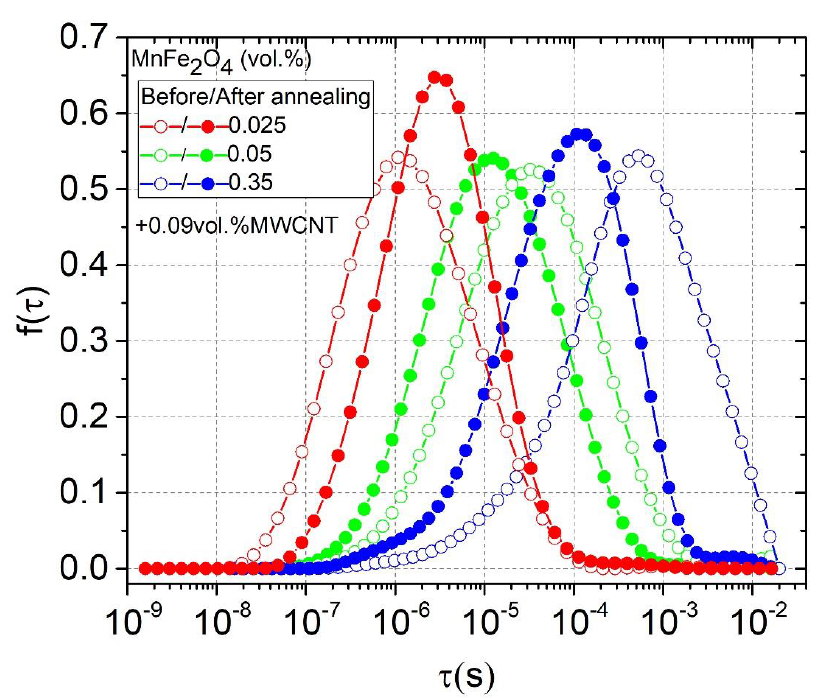
Figure 8. Relaxation time distributions before and after annealing at 500 K.